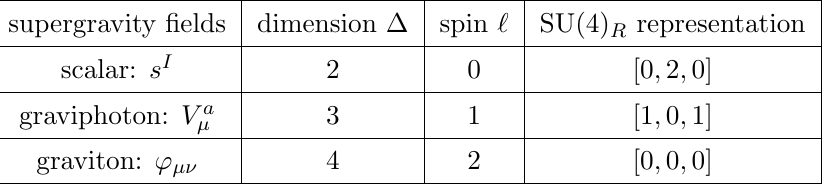
4 20 0 (cid:12)ve-point function from